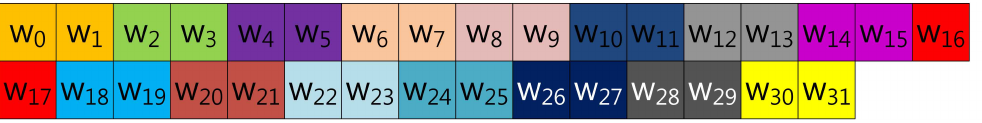
Figure 18. Look-up table structure of the traditional 2NAF method in block form.